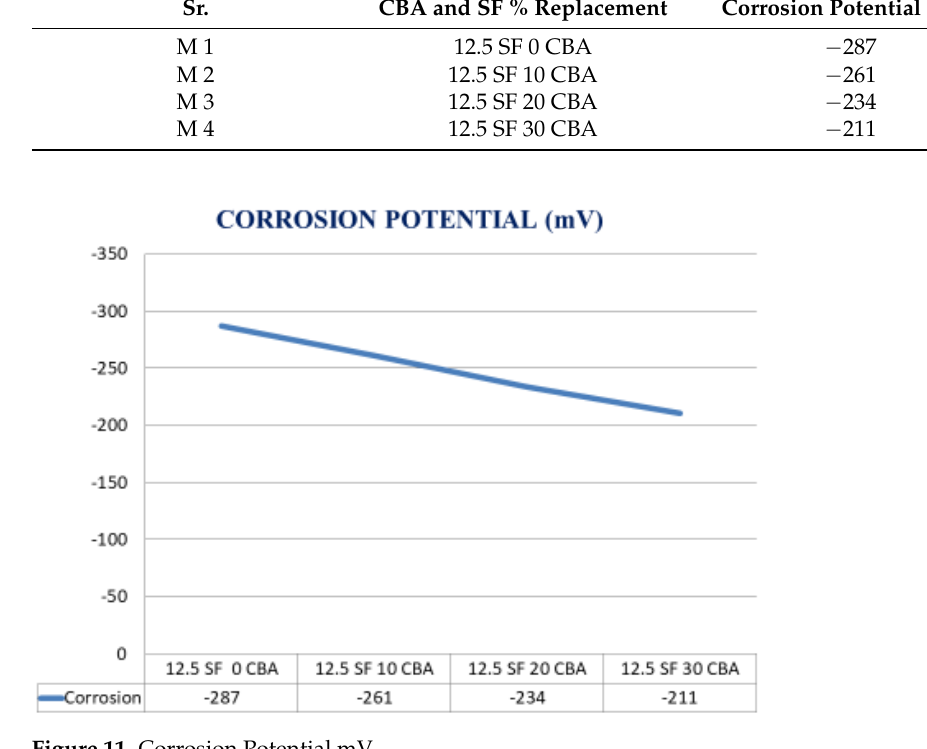
Figure 11. Corrosion Potential mV.